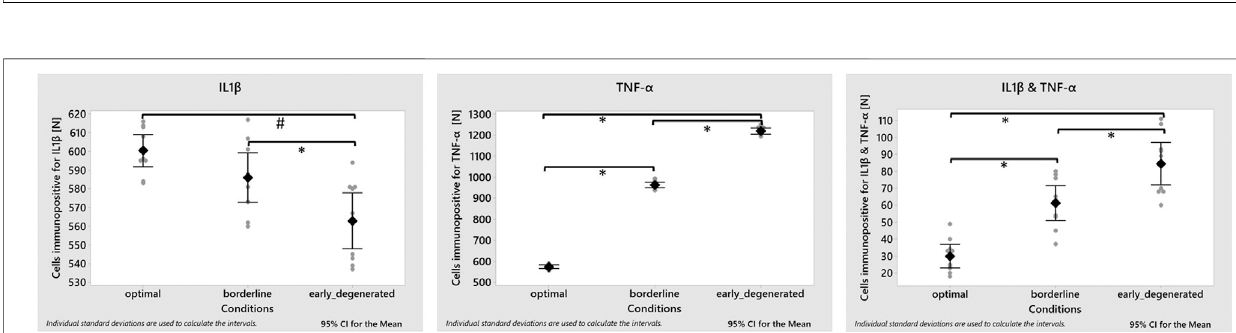
FIGURE 8 | Completed system of interest according to additional experimental data. Blue arrows: activating links; Red arrows: inhibiting links; Dashed arrows: statistically non-signi fi cant tendencies.